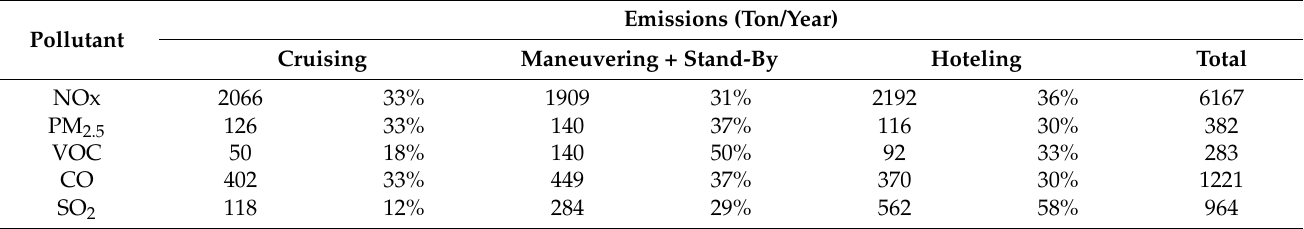
Table A15. Total emissions from vessels (Haifa, MPS A1